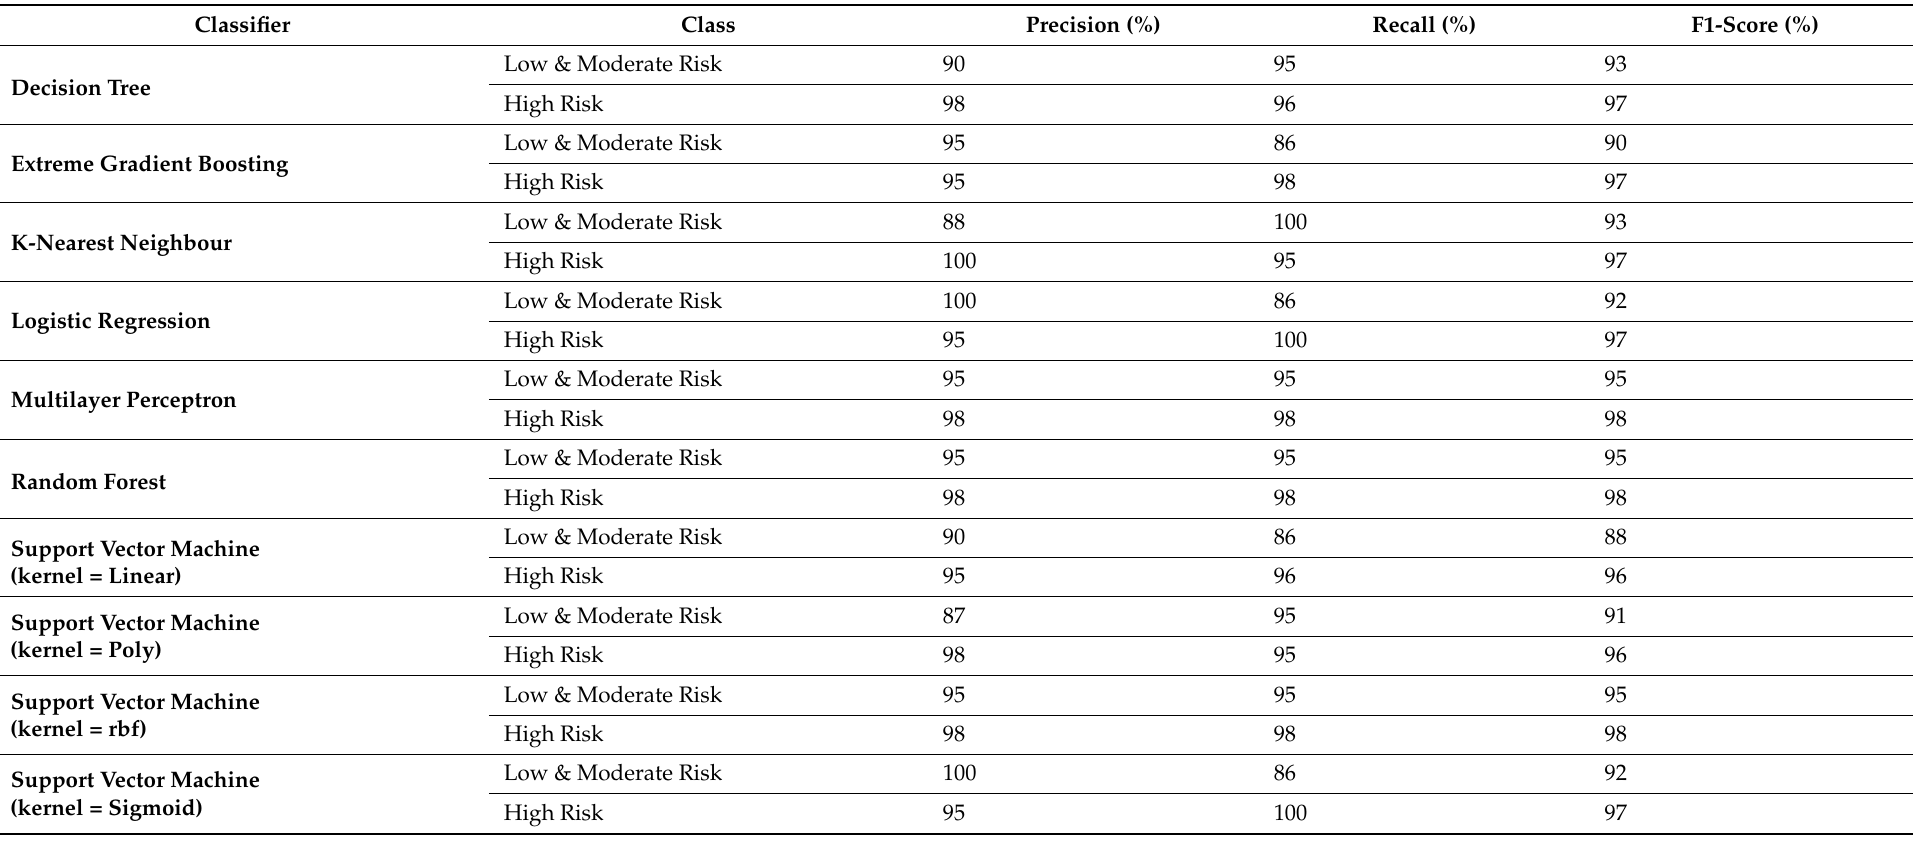
Table 3. Classifiers in detail in terms of precision, recall, and F1-score for 2 different types of